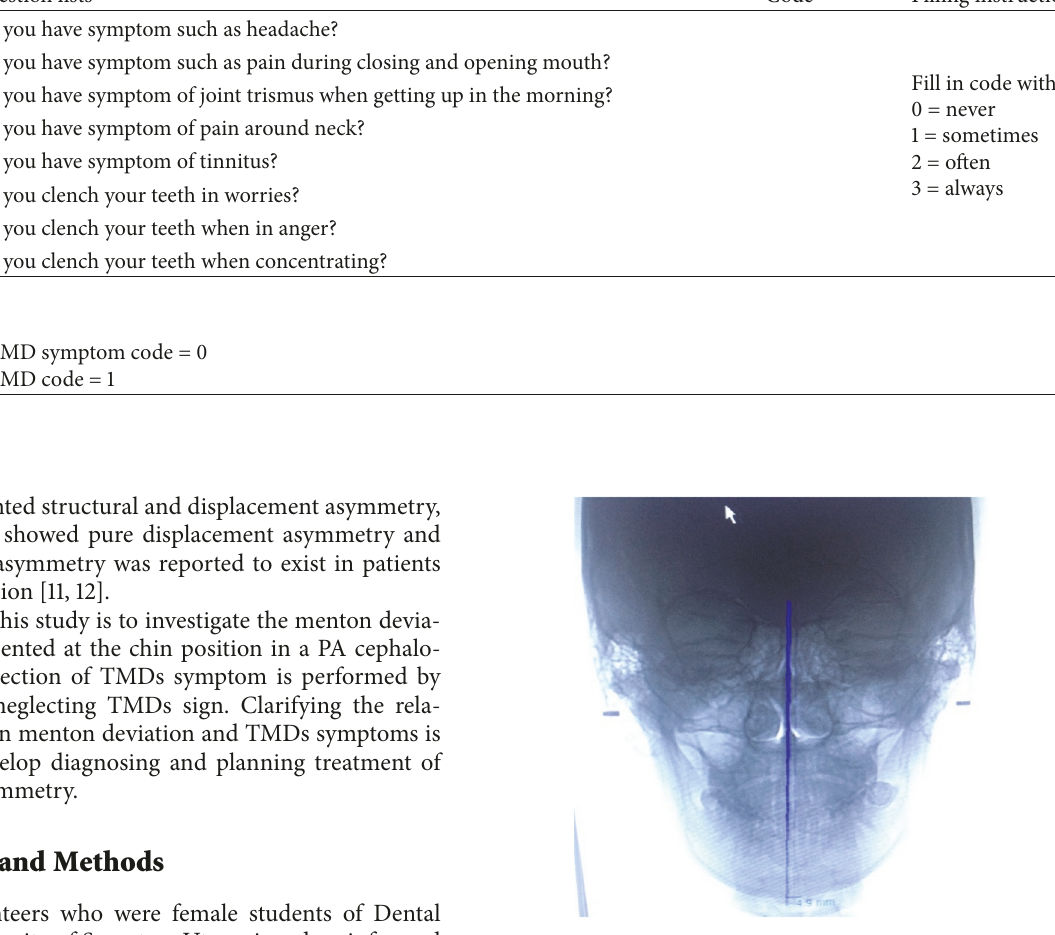
Figure 1: Menton deviation to MSR in PA cephalogram digital